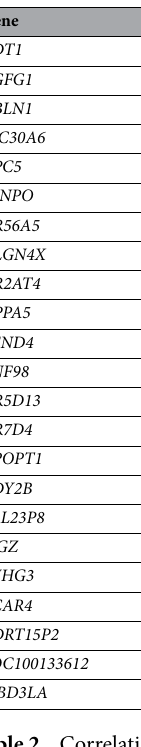
Table 2. Correlation between the extent of atypical hepatocytes and ΔCt value of the 23 genes in frozen noncancerous liver tissues in Cohort 3. (n = 62). ΔCt = Ct for each of interest − Ct β-actin Data were analyzed using the Spearman’s rank correlation test. AGFG1, ArfGAP with FG repeats 1; APOPT1, cytochrome c oxidase assembly factor 8 (COA8); BCAR4, breast cancer anti-estrogen resistance 4; BEND4, BEN domain containing 4; CDRT15P2, CMT1A duplicated region transcript 15 pseudogene 2; CDT1, chromatin licensing and DNA replication factor 1; CDY2B, chromodomain Y-linked 2B; DPPA5, developmental pluripotency associated 5; FBLN1, fibulin 1; LOC100133612: LOC1134 (Gene ID: 100133612), long intergenic nonprotein coding RNA 1134; NLGN4X, neuroligin 4 X-linked; MBD3L1, methyl-CpG binding domain protein 3 like 1; OR2AT4, olfactory receptor family 2 subfamily AT member 4; OR56A5, olfactory receptor family 56 subfamily A member 5; OR5D13, olfactory receptor family 5 subfamily D member 13; OR7D4, olfactory receptor family 7 subfamily D member 4; PIGZ, phosphatidylinositol glycan anchor biosynthesis class Z; RPL23P8, ribosomal protein L23 pseudogene 8; SLC30A6, solute carrier family 30 member 6; GPC5, glypican 5;SNHG3, small nucleolar RNA host gene 3; SYNPO, synaptopodin; ZNF98, zinc finger protein